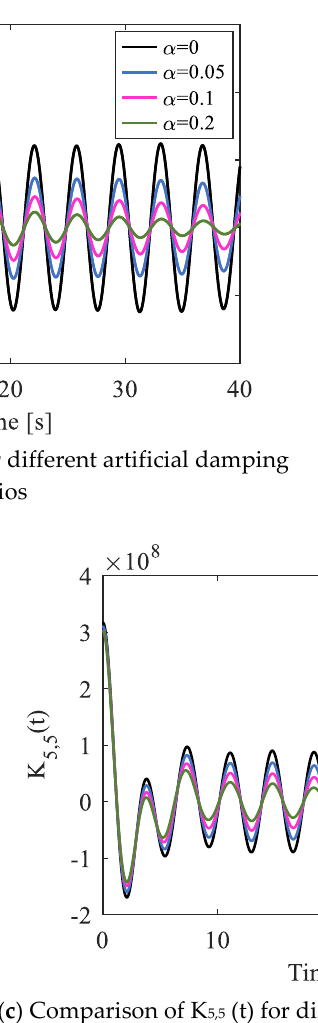
Figure 13. Comparison of the calculated impulse response function K(t) for the windward module of the 3-module model with different artificial damping ratios, α.